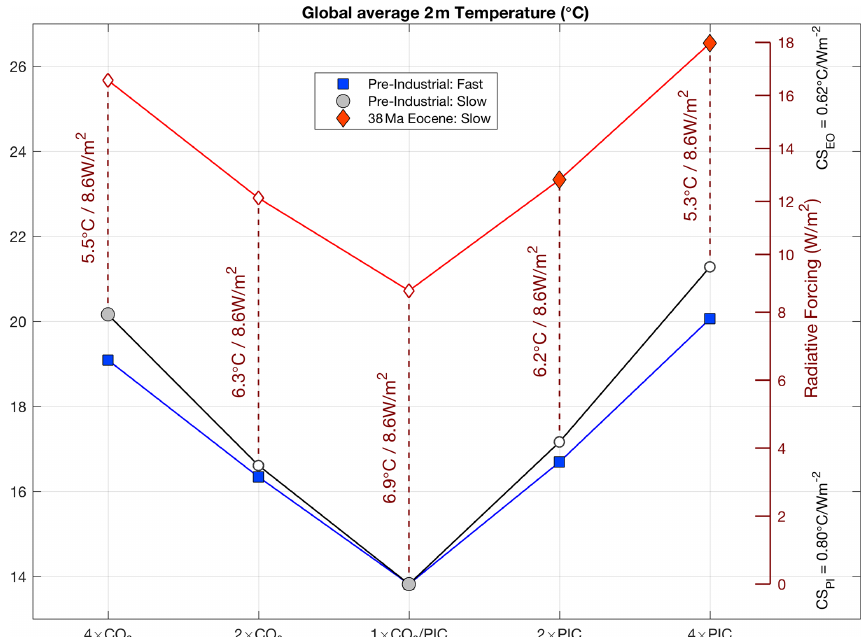
Figure 10. Overview of globally averaged near-surface air temperatures in the different pre-industrial reference (blue) and 38Ma Eocene (red) simulations. Blue squares show the extrapolated temperature response of fast feedbacks from 20-year perturbations (4 × CO 2 , 2 × CO 2 , 2 × PIC, and 4 × PIC), while grey circles also include that of slow feedbacks. Filled markers indicate results from equilibrated simulations, and open markers show values that were estimated from the model-derived climate sensitivity and radiative forcing (red axis to the right; note the change in scale between pre-industrial and Eocene using S PI and S EO , respectively). Offsets in both temperature and radiative forcing (i.e. G ) between pre-industrial and 38Ma Eocene cases are specified for all of the considered atmospheric